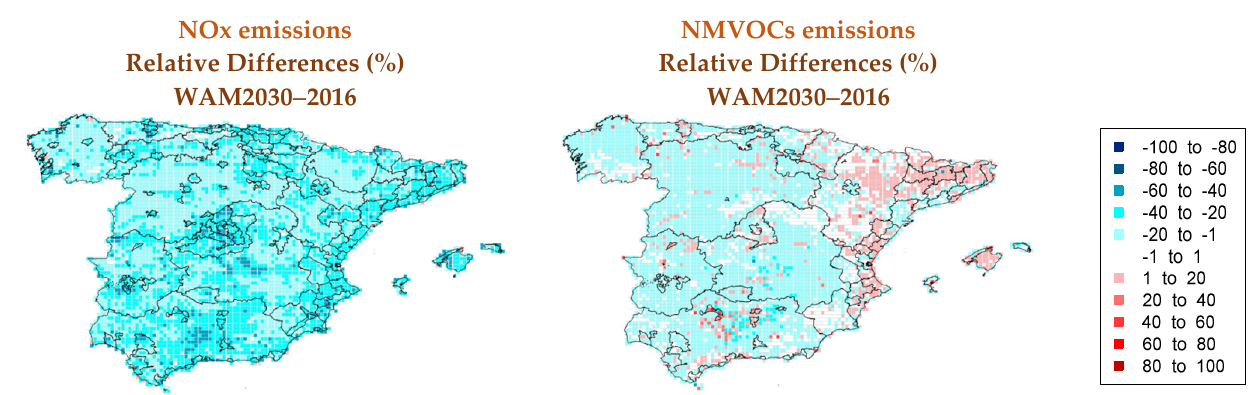
Figure A5. Relative differences (%) of annual NO x (left) and NMVOC (right) emissions between the WAM2030 scenario and 2016.